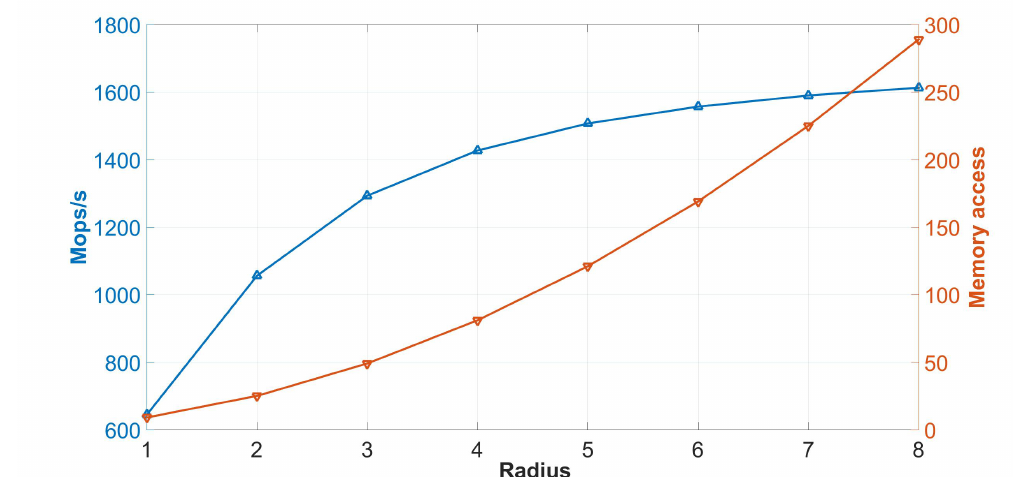
Figure 12. Left axis : Mops/s performed with different radii, at a frequency of 100 MHz. Right axis : memory accesses performed.